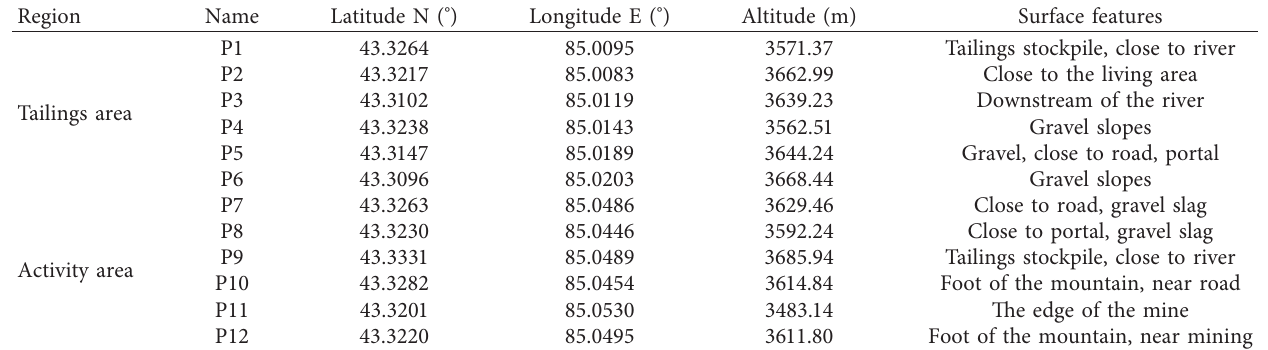
Table 1: Basic information of the deformation observation points.